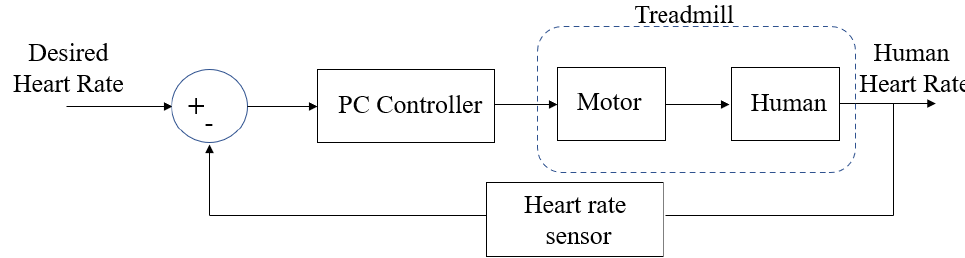
Figure 1. Experimental setup block diagram